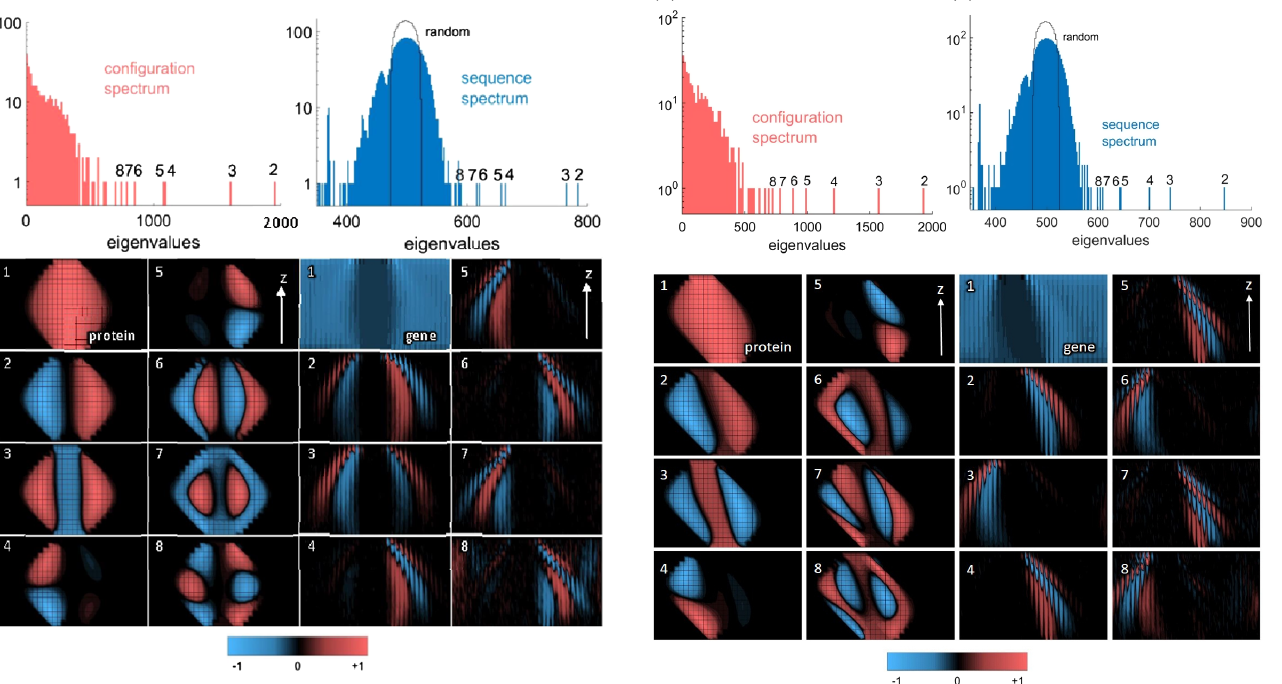
FIG. 7. Spectra and eigenfunctions for the tilted example ( T ). Note the similarity with Fig. 6, and also how the tilt is manifested not only in the protein modes, but also in the gene modes. This demonstrates that the gene and the protein share common features. (a) The configuration spectrum and eigenfunctions.